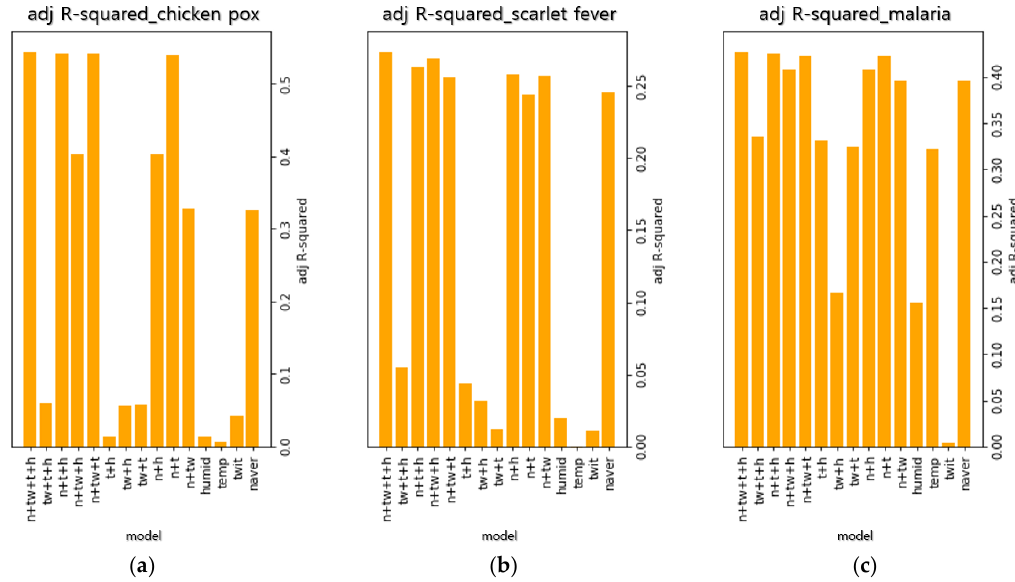
Figure 2. Variable optimization parameters. ( a ) Adjusted R-squared values of 15 regression models in chickenpox, ( b ) Adjusted R-squared values of 15 regression models in scarlet fever, ( c ) Adjusted R-squared values of 15 regression models in malaria.